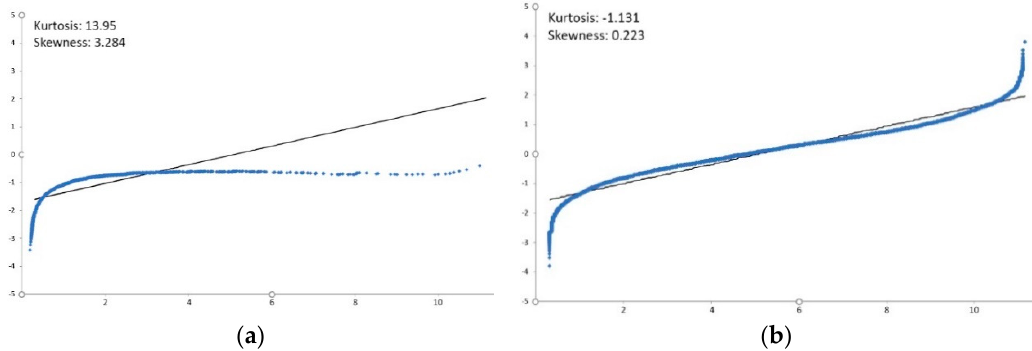
Figure 6. An example of quantile-quantile (Q-Q) plots for the unfiltered ( a ) and filtered ( b ) a-posteriori standard deviation values (mm) and related Skewness and Kurtosis values for the Modena Cathedral dataset. The quantiles of input sample (vertical axis) are plotted against the standard normal quantiles (horizontal axis). In the filtered case ( b ), values approximate better to the straight line, assuming a more relevant normal behaviour.